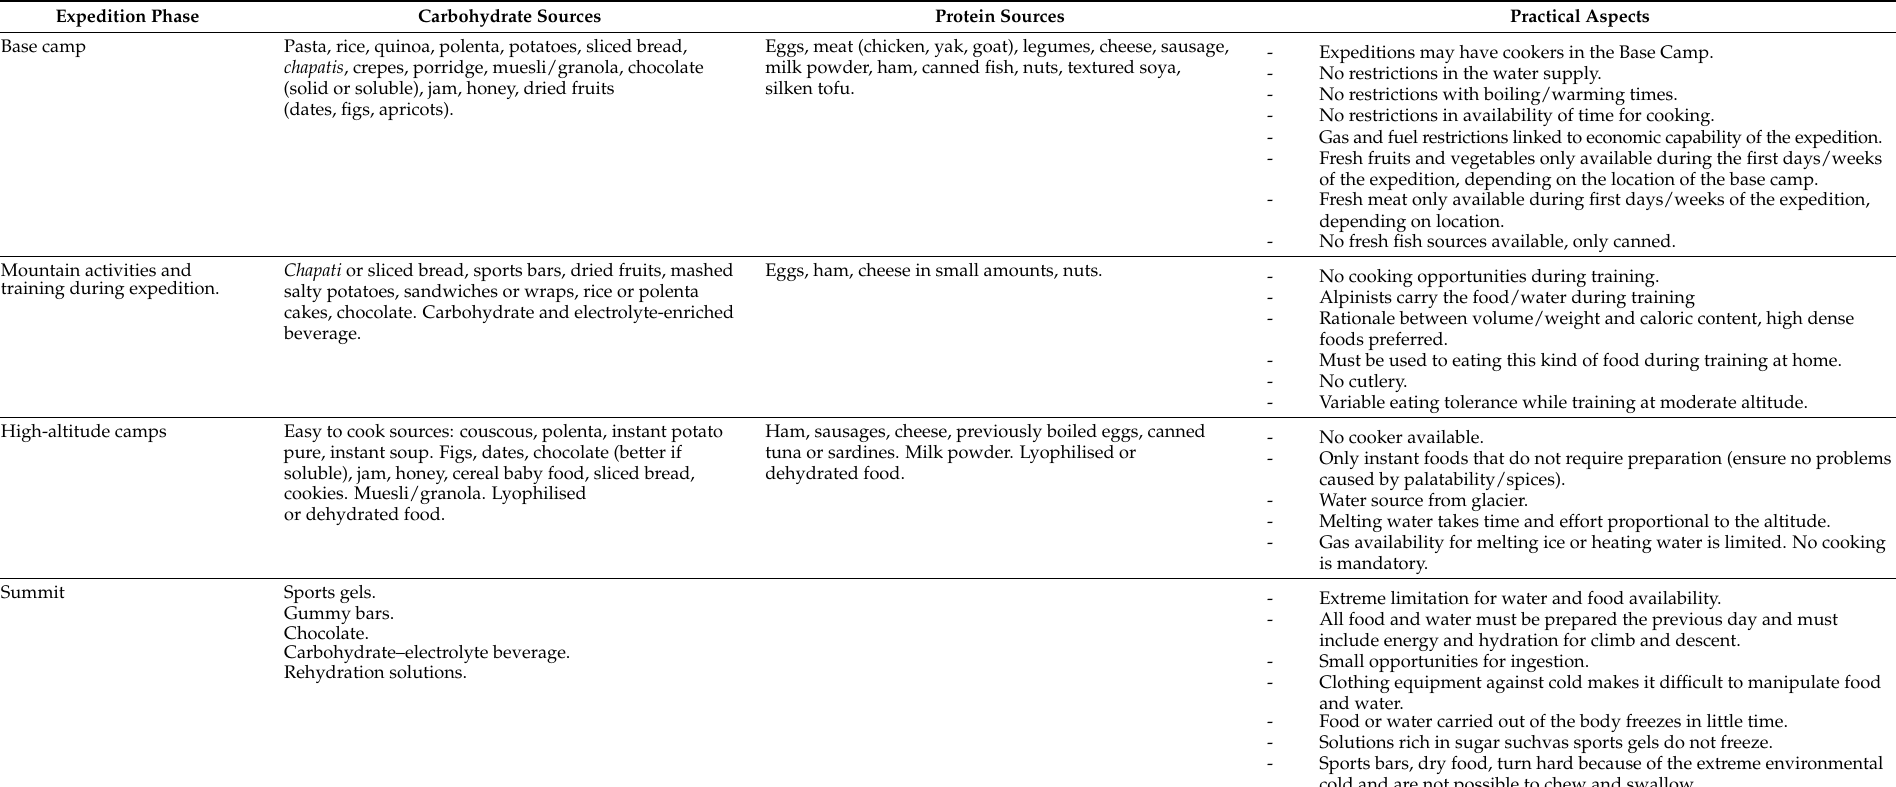
Table 6. The main carbohydrate and protein sources in high-altitude expeditions.